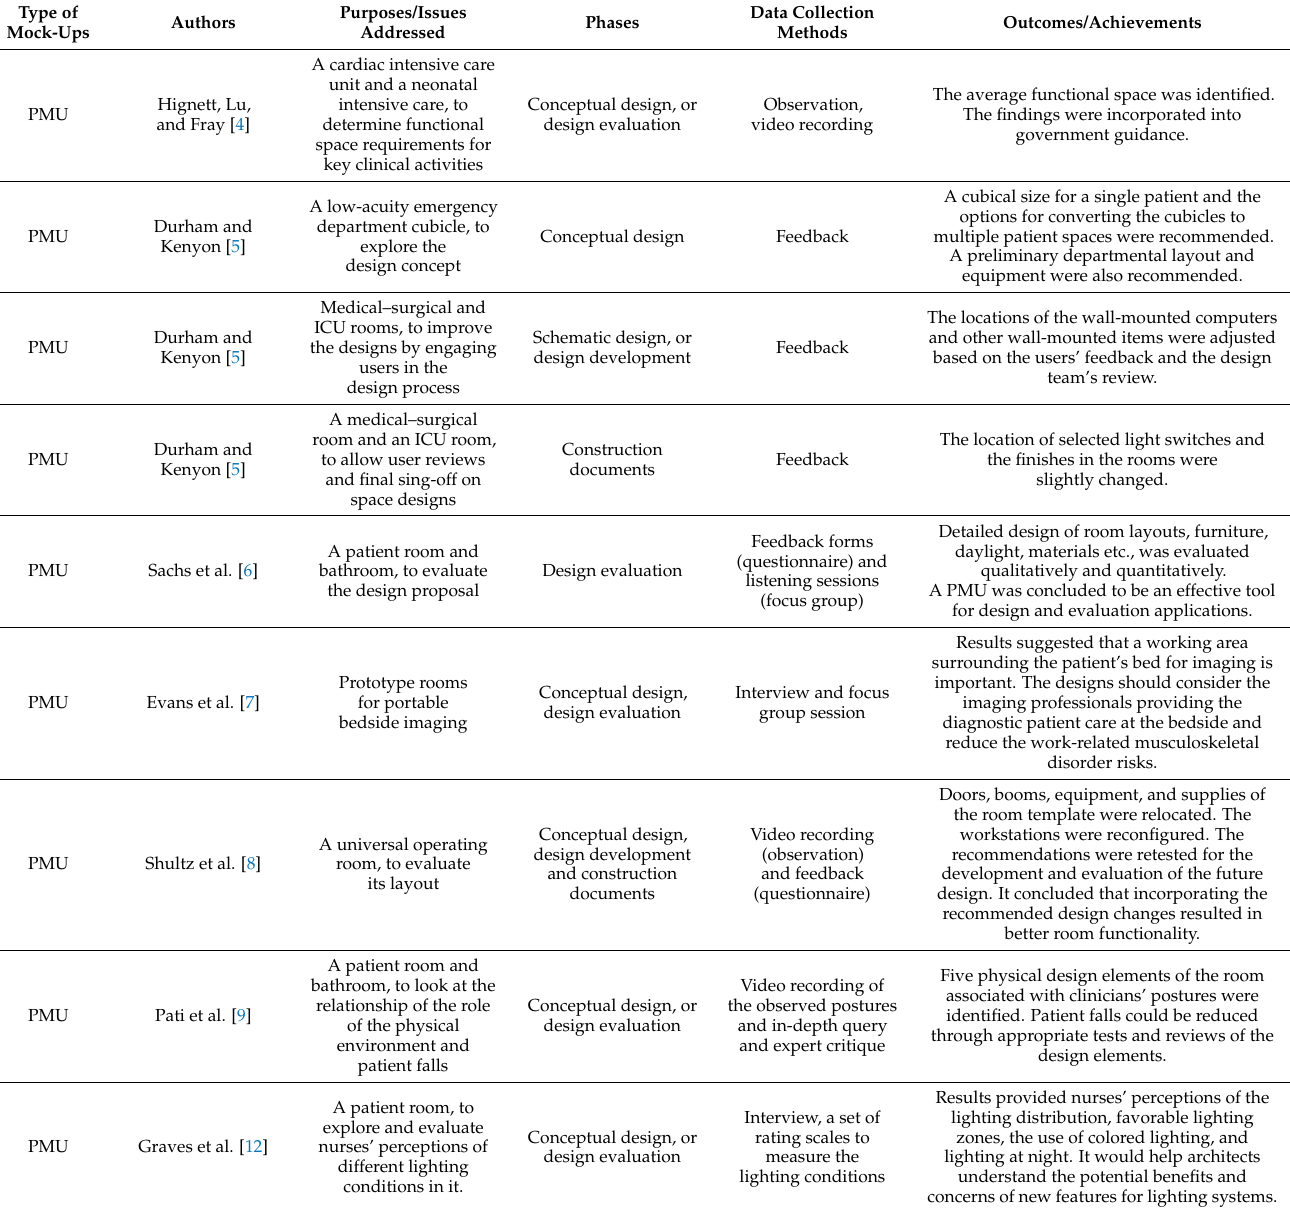
Table 2. Summary of empirical studies of applying mock-ups to healthcare design and